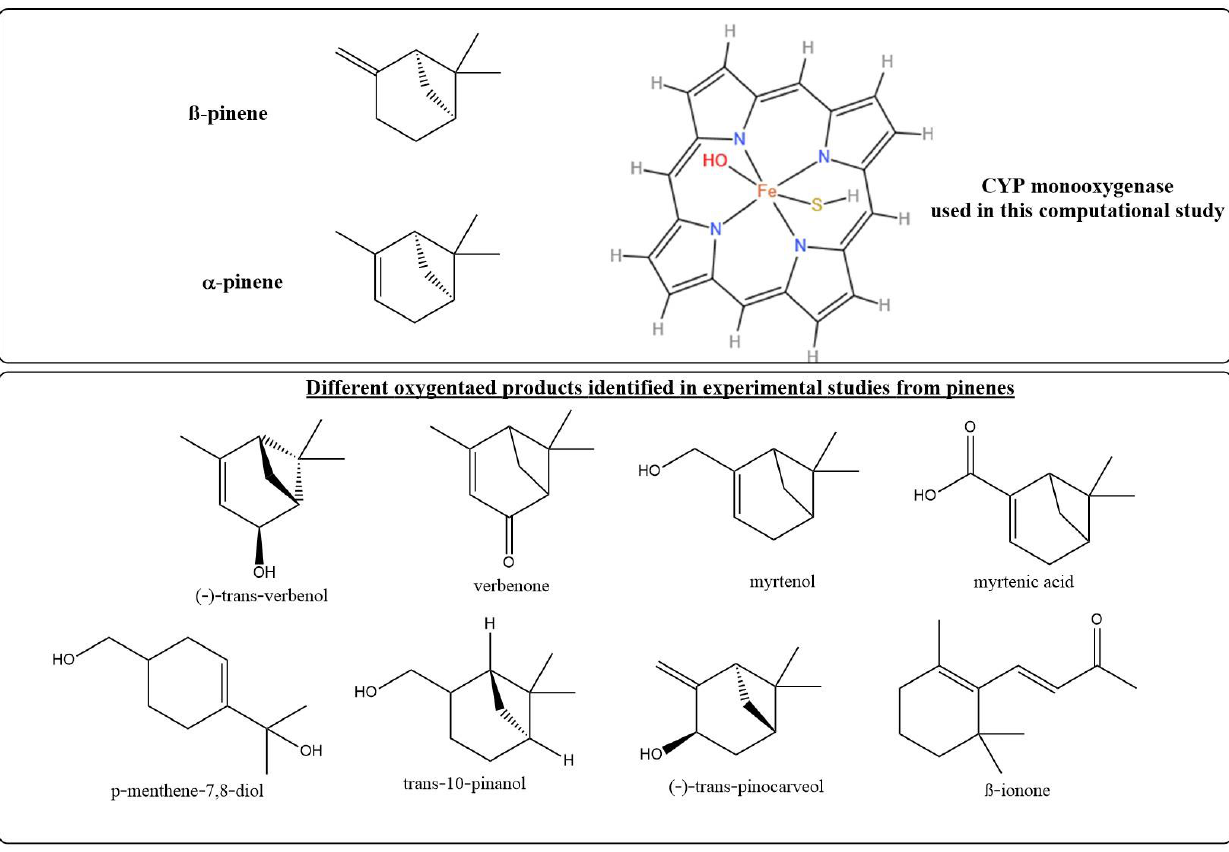
Figure 1. Structures of α - pinene, β -pinene, the CYP monooxygenase model, and the different oxygenated products from pinenes reported in the literature.